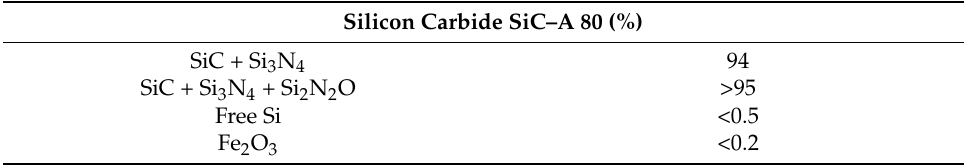
Table 2. Chemical composition of the material under